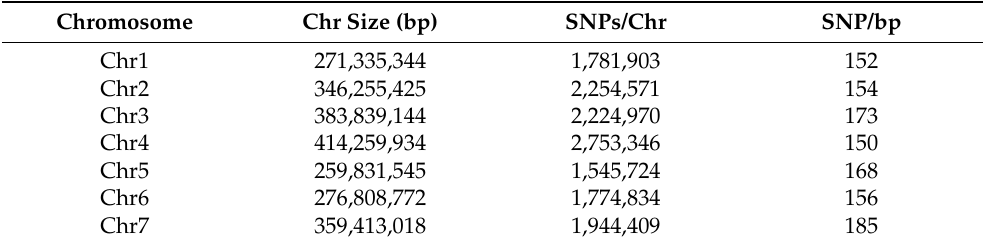
Table 2. Summary of SNPs distribution. Perennial ryegrass chromosome size (Chr size (bp)), number of SNPs identified per chromosome (SNPs/Chr), and the average SNP density (SNP/bp). A total of 259,221 SNPs were located on scaffolds.